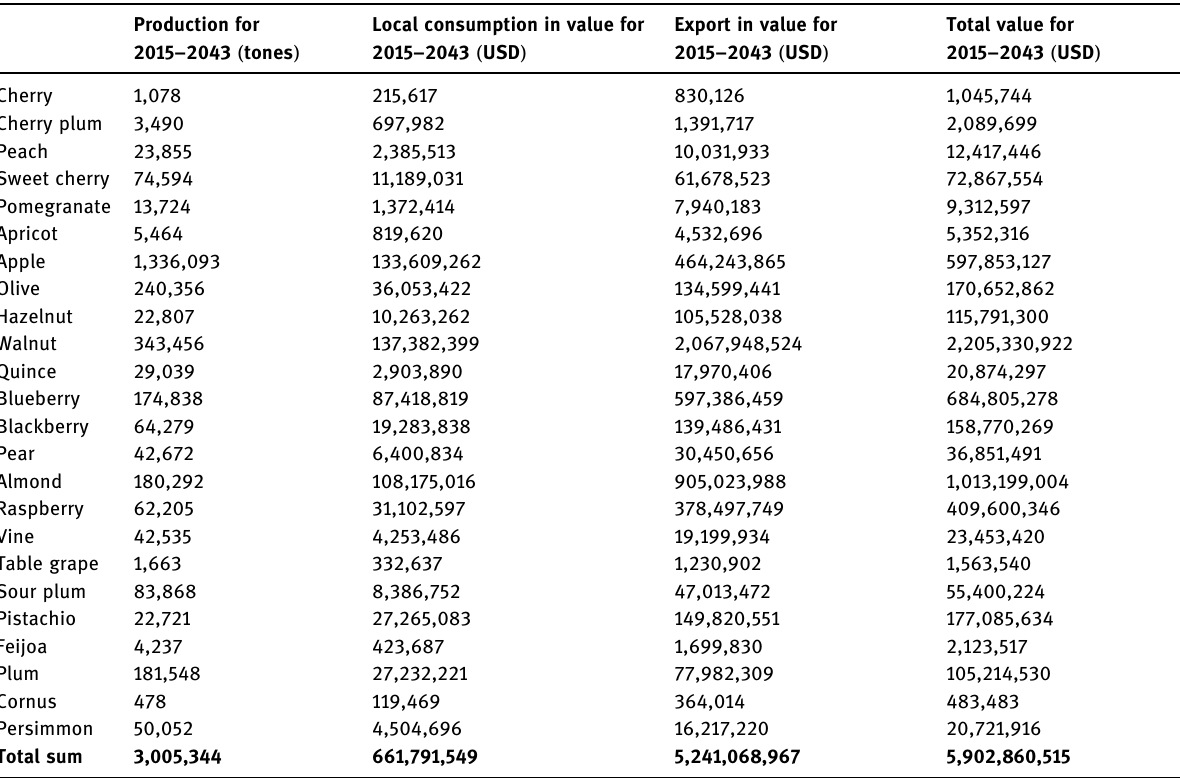
Table 5: Production, local consumption, and export by agricultural goods Production